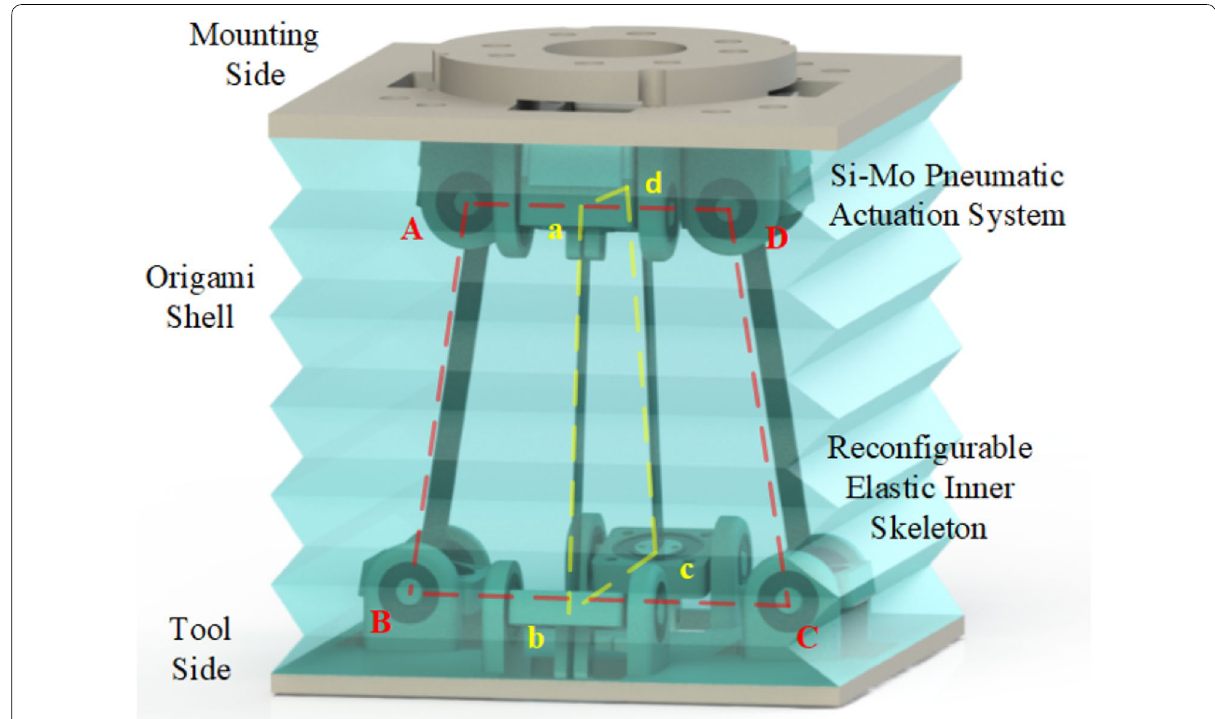
Figure 1 Structure of the proposed variable stiffness device